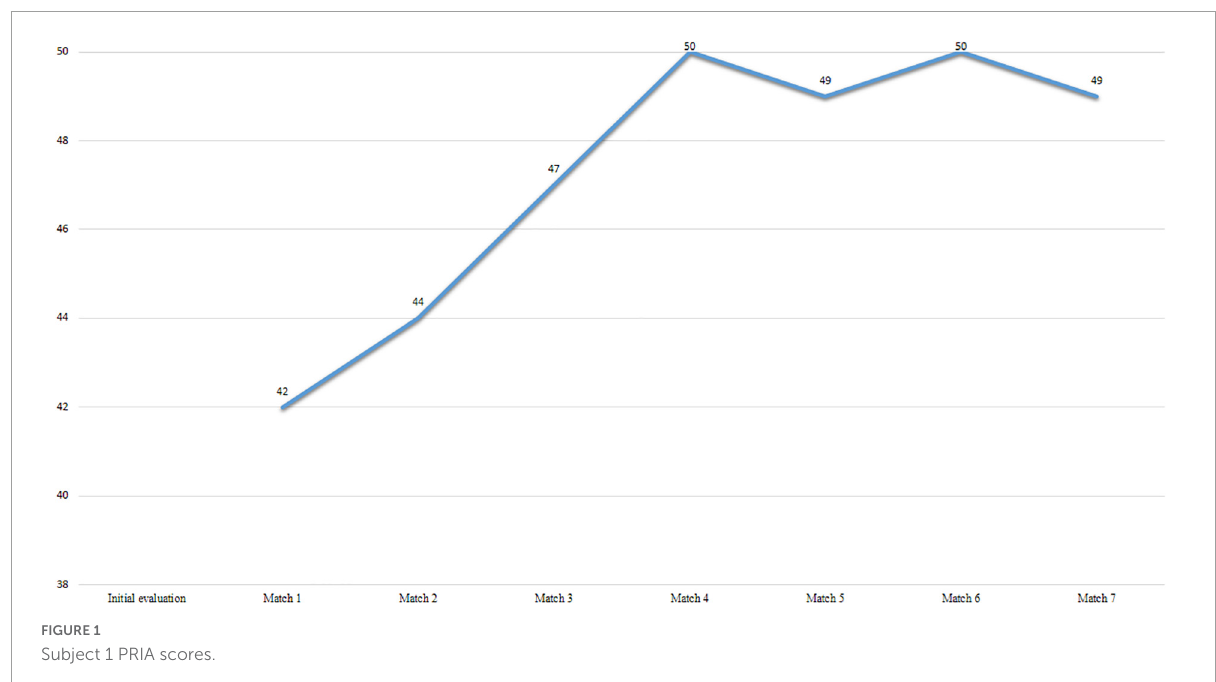
FIGURE1 Subject 1 PRIA scores.